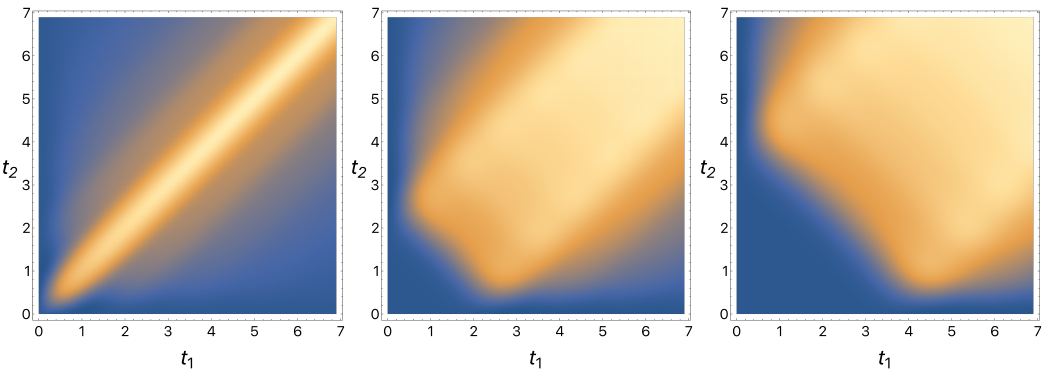
Figure 5: Density plots of the connected non-equal time correlation 〈 σ x ( t ) σ x ( t ) 〉 after a quantum quench as a function of t (cid:96) + 1 c 2 1 1 from left to right. The three plots use different color